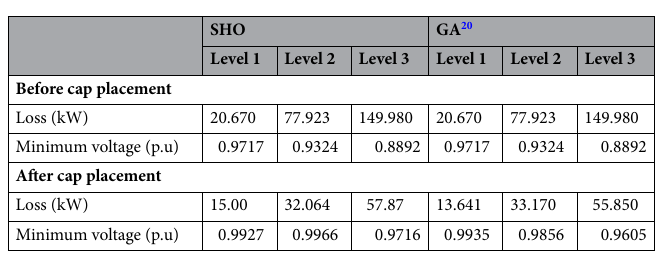
Table 8. Losses and minimum load voltage before and after the capacitor placement in the scenario of islanding with cosφ =